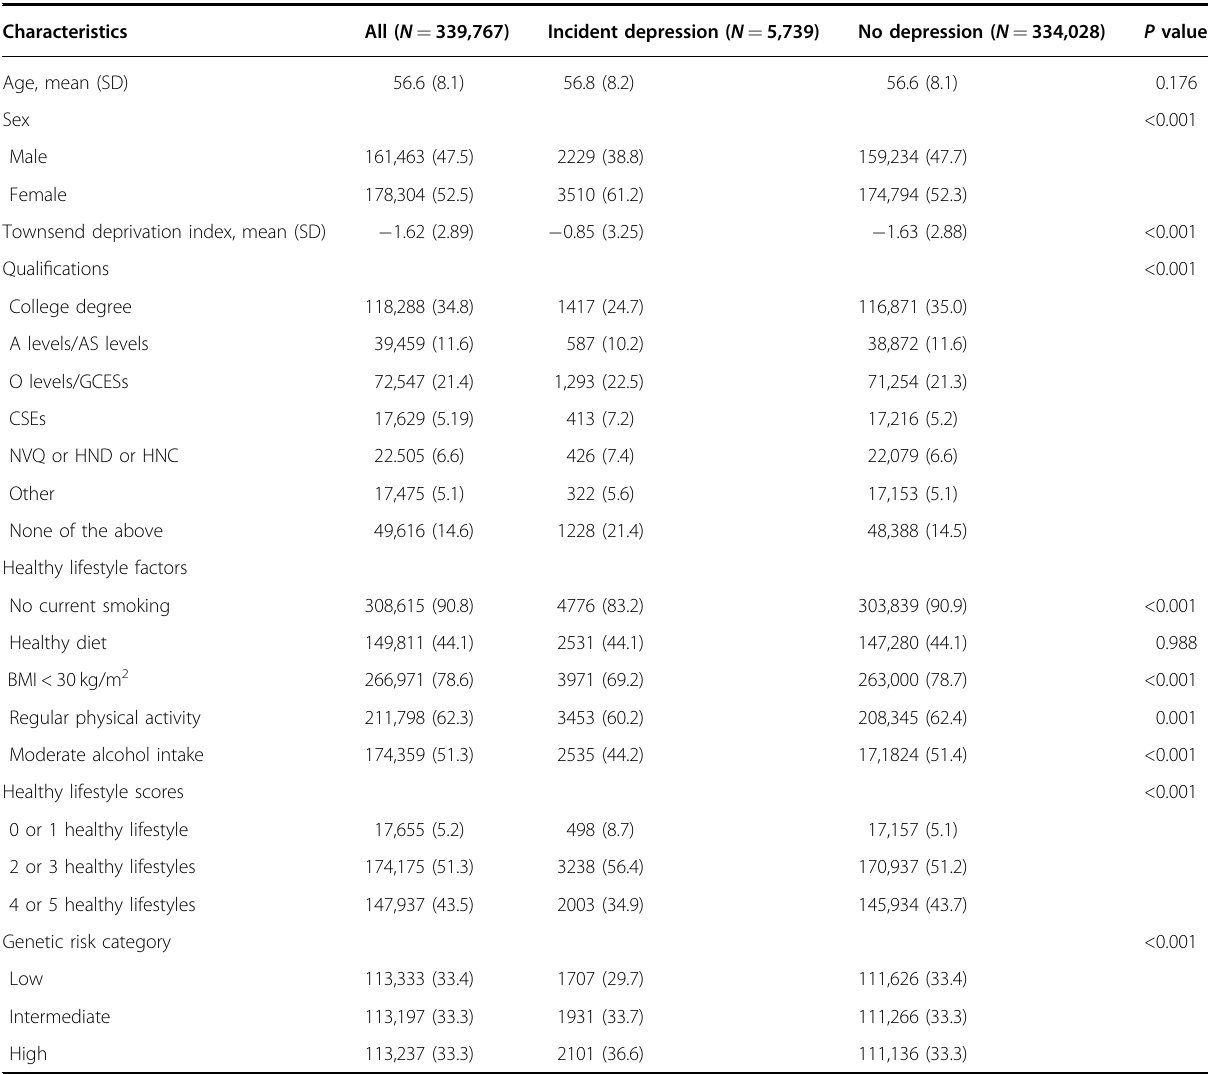
Table 1 Characteristics of participants at